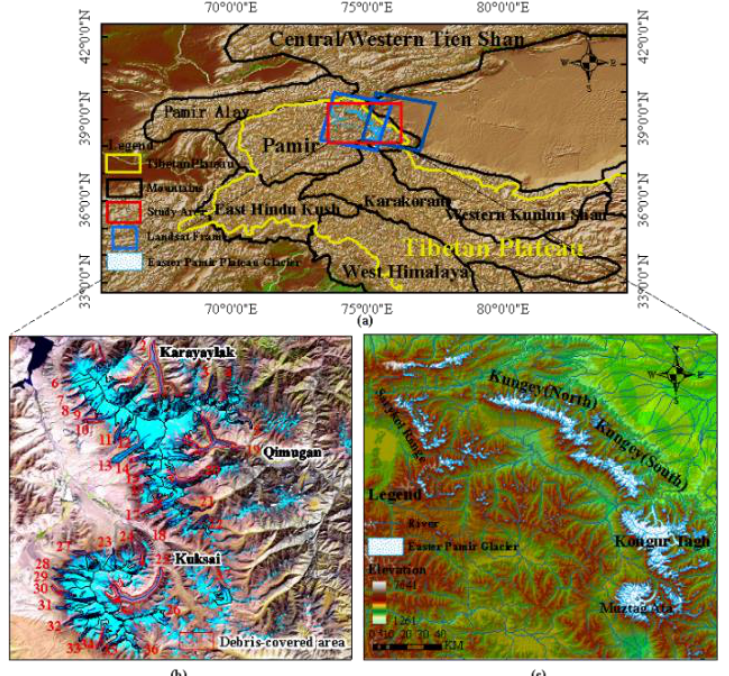
Figure 1. Study area. ( a ) The red square is the study area and the blue squares are Landsat scenes. ( b ) Study area overlaid on a Landsat-8 Operational Land Imager (OLI) false-colored composite image (red = 5, green = 4, blue = 3) acquired on 29 September 2019. It shows the glaciers with an area of more than 5 km 2 in the Muztag-Kongur Mountains. The red polygons are areas covered by debris on the glacier. ( c ) Overall distribution of glaciers with respect to the elevation. The coordinates of the study area are between 38°N –39°N and 74°40′E–75°40′E.